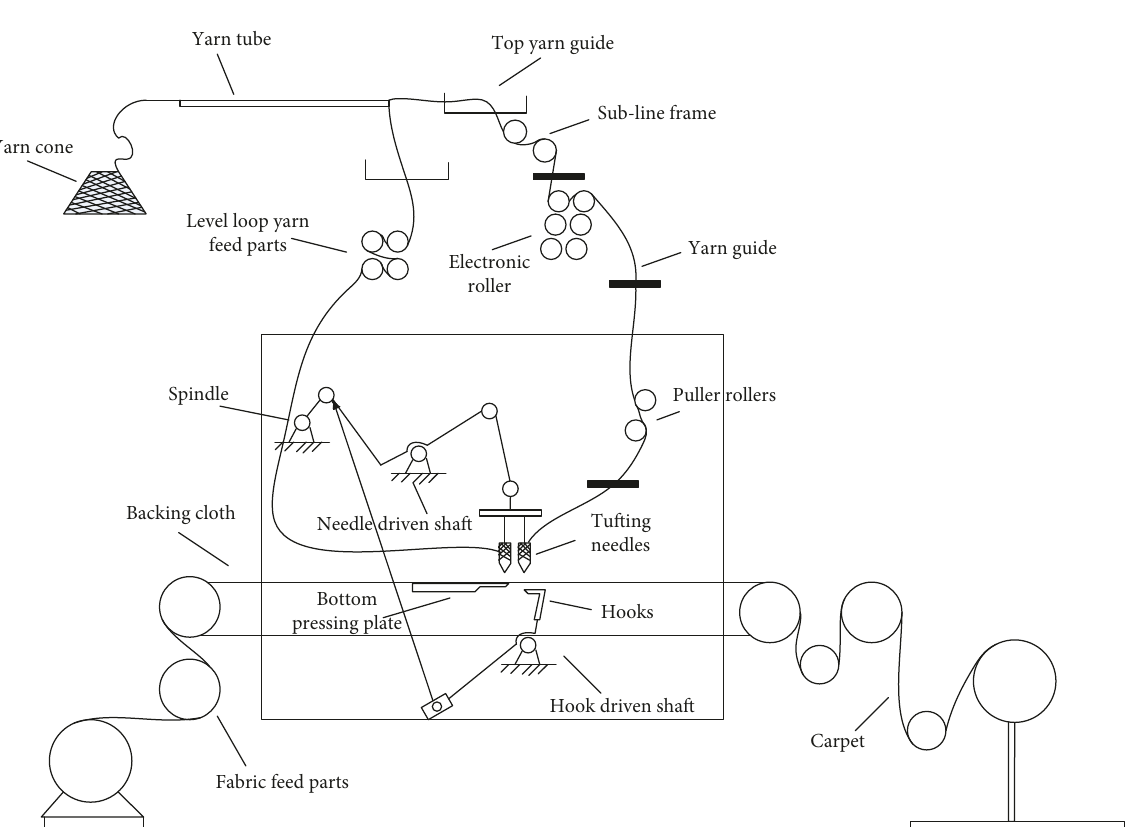
Figure 4: The structure diagram of a carpet tufting